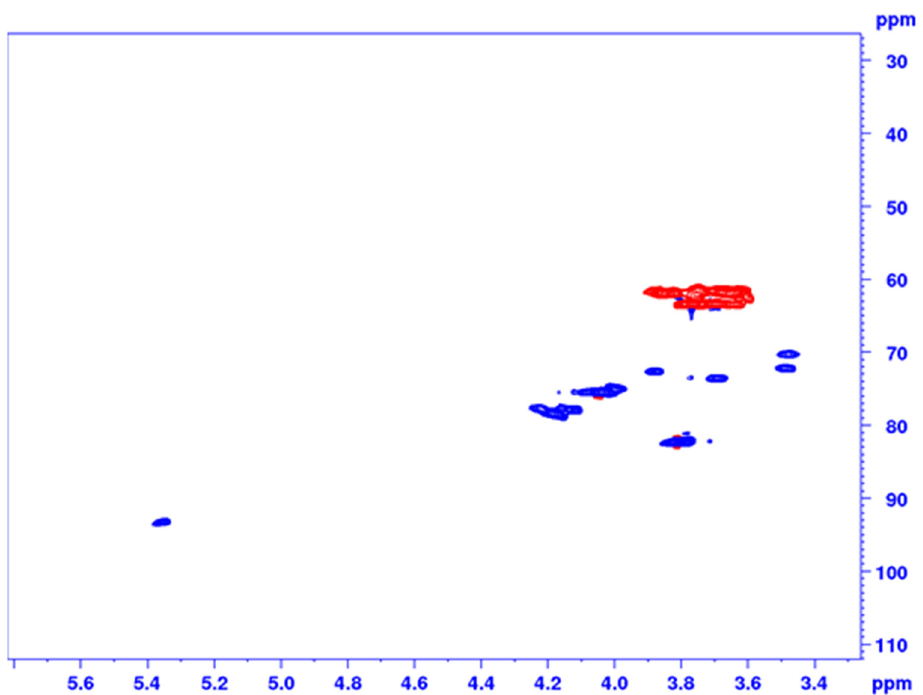
Figure 2 1 H- 13 C multiplicity-edited HSQC spectrum of AR2. Figure 2. 1 H- 13 C multiplicity-edited HSQC spectrum of